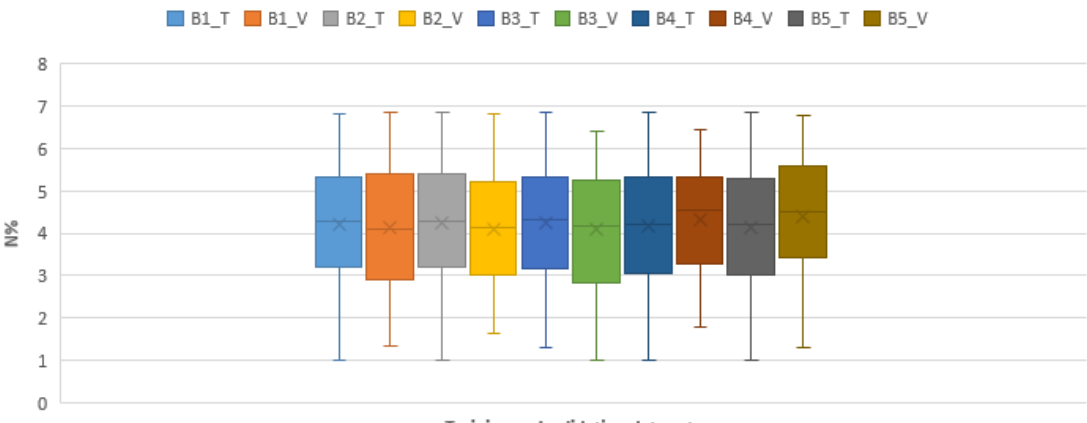
Figure A4. Distributions of reference N% values for the five-fold cross-validation. B1_T represents the training data of batch 1 and B1_V represents the validation data of batch 1, so on and so forth. This figure shows that the distributions of the training and validation data set are close to normal distributions and there are no clear statistical differences in the training and validation dataset; thus the data is reasonable for training and validating the models.